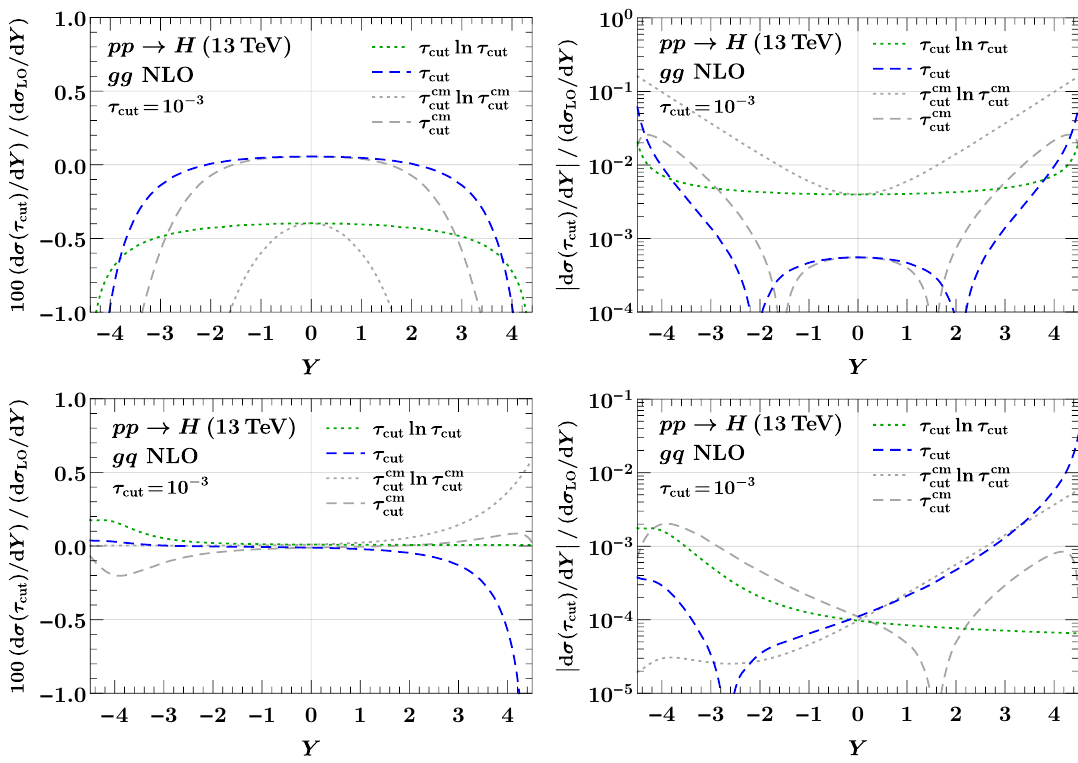
Figure 11 . The NLO NLP corrections as a function of rapidity at (cid:12)xed (cid:28) cut = 10 (cid:0) 3 for Higgs production for the gg channel (top row) and the gq channel (bottom row). The LL and NLL coe(cid:14)cients for leptonic T are shown by the green dotted and blue dashed curves and for hadronic T by the dotted and dashed gray